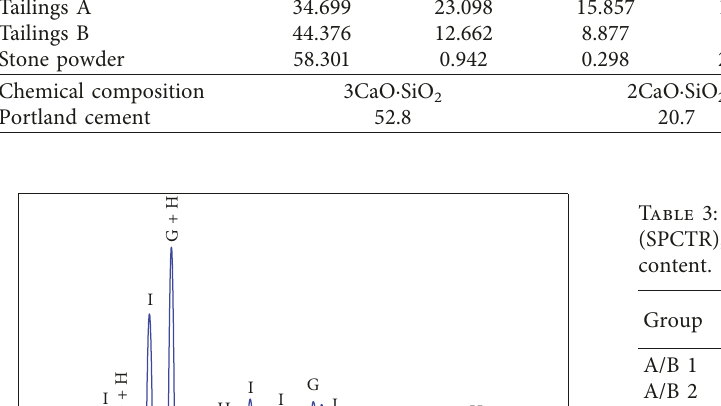
Table 2: Elemental composition of the tailings and the stone powder along with the chemical composition of Portland cement (%). Elemental composition